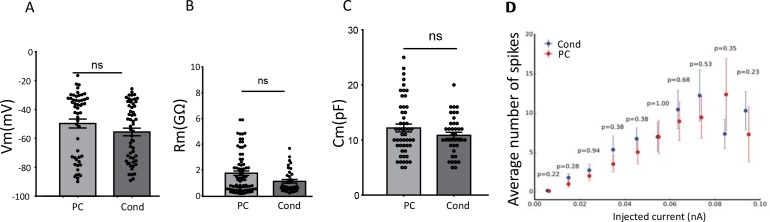
The biophysical properties of adult-born neurons.Explicit learning did not modify (A) the resting membrane potential (Mann-Whitney: PC vs Cond p=0.12). (B) the membrane resistance (Mann-Whitney: PC vs Cond p=0.1) or (C) the membrane capacitance of adult-born neurons (Mann-Whitney: PC vs Cond p=0.16) (Pseudo-conditioned: PC; Conditioned: Cond). (D) The input-output curves of adult-born cells produced by 500 ms steps of injected currents at different intensities were not modified by explicit learning (PC n = 37 and Cond n = 49 cells). Only neurons that were not silent were considered (Mann Whitney, p>0.05). The data are expressed as mean values ± SEM.